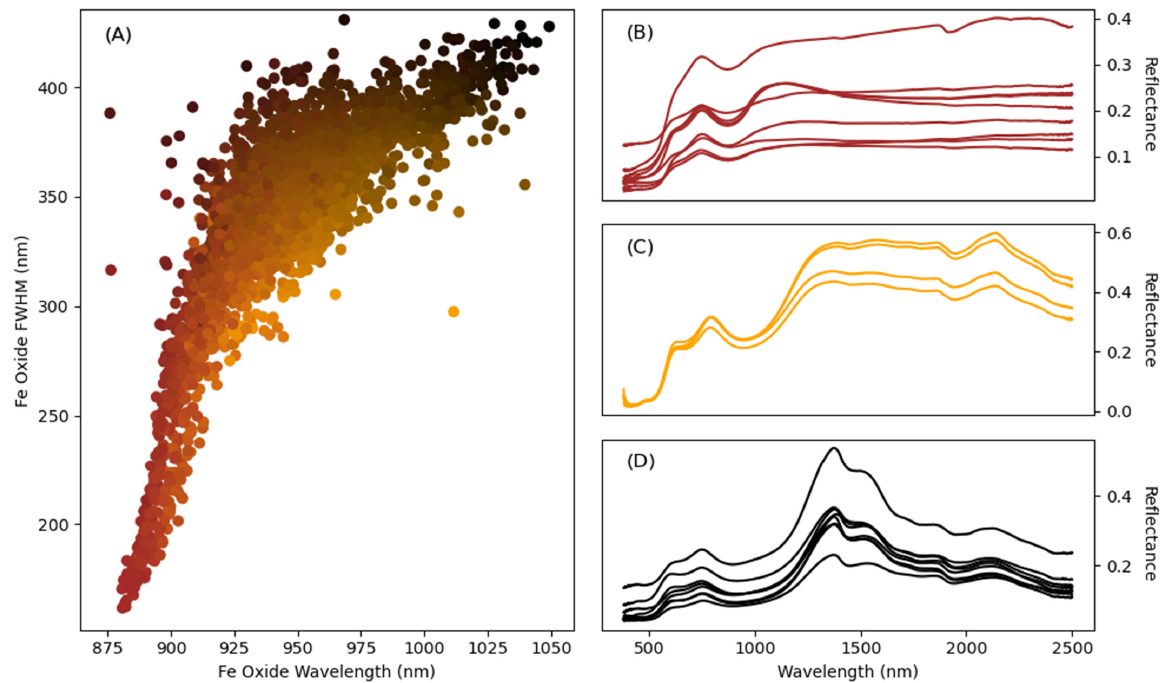
Figure 16. ( A ) The false colour iron boomerang for drillcore 3 coloured in the same manner as the downhole plots, ( B ) in-situ selected hematite endmembers, ( C ) library selected ochreous goethite endmembers, and ( D ) in-situ selected vitreous goethite endmembers.